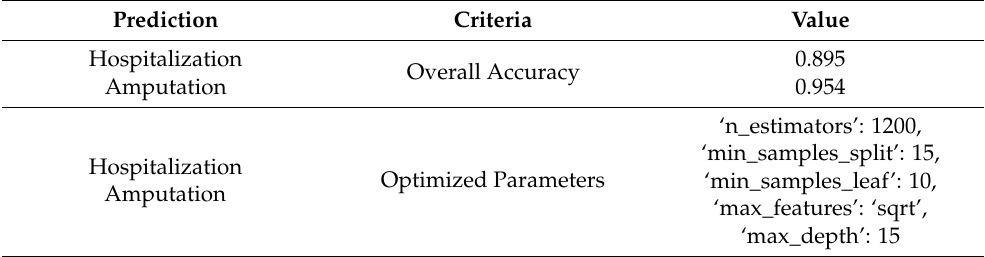
Table 7. Hyperparameter Tuning